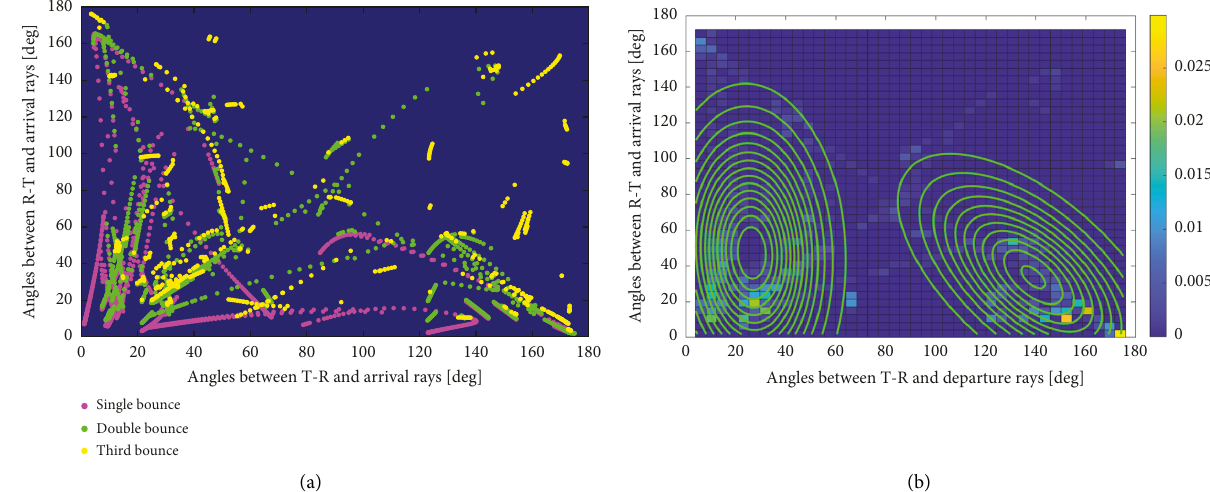
Figure 6: Statistics results of (a) angular trajectories of rays; (b) histogram of quasi-AoAs and quasi-AoDs.